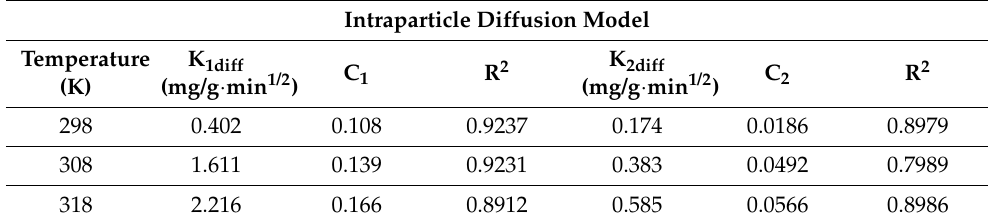
Table 2. The intraparticle diffusion model parameters for the adsorption of Ru(III) onto Ch-DB30C10. Intraparticle Diffusion Model